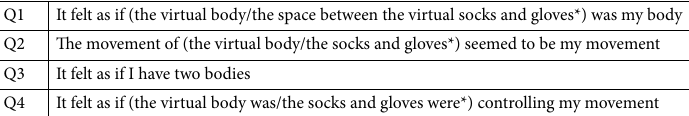
Table 1. Questionnaire items. *These statements were used for the avatar hands and feet only